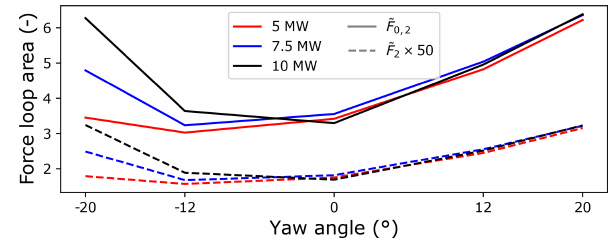
Figure C4. Non-dimensionalised, downwind-row, radial load-loop- area results for various yaw angles for overhung ( ˜ F 0 , 2 ) and centred ( ˜ F 2 ) support main-bearing configurations across the three modelled